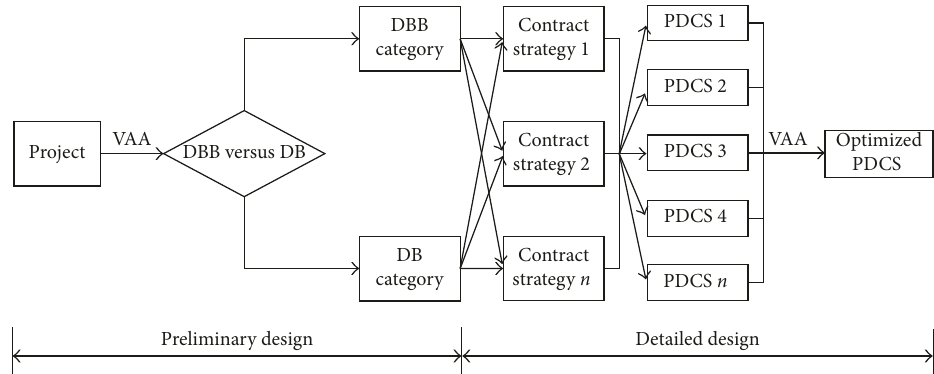
Figure 5: General process model for the PDCS